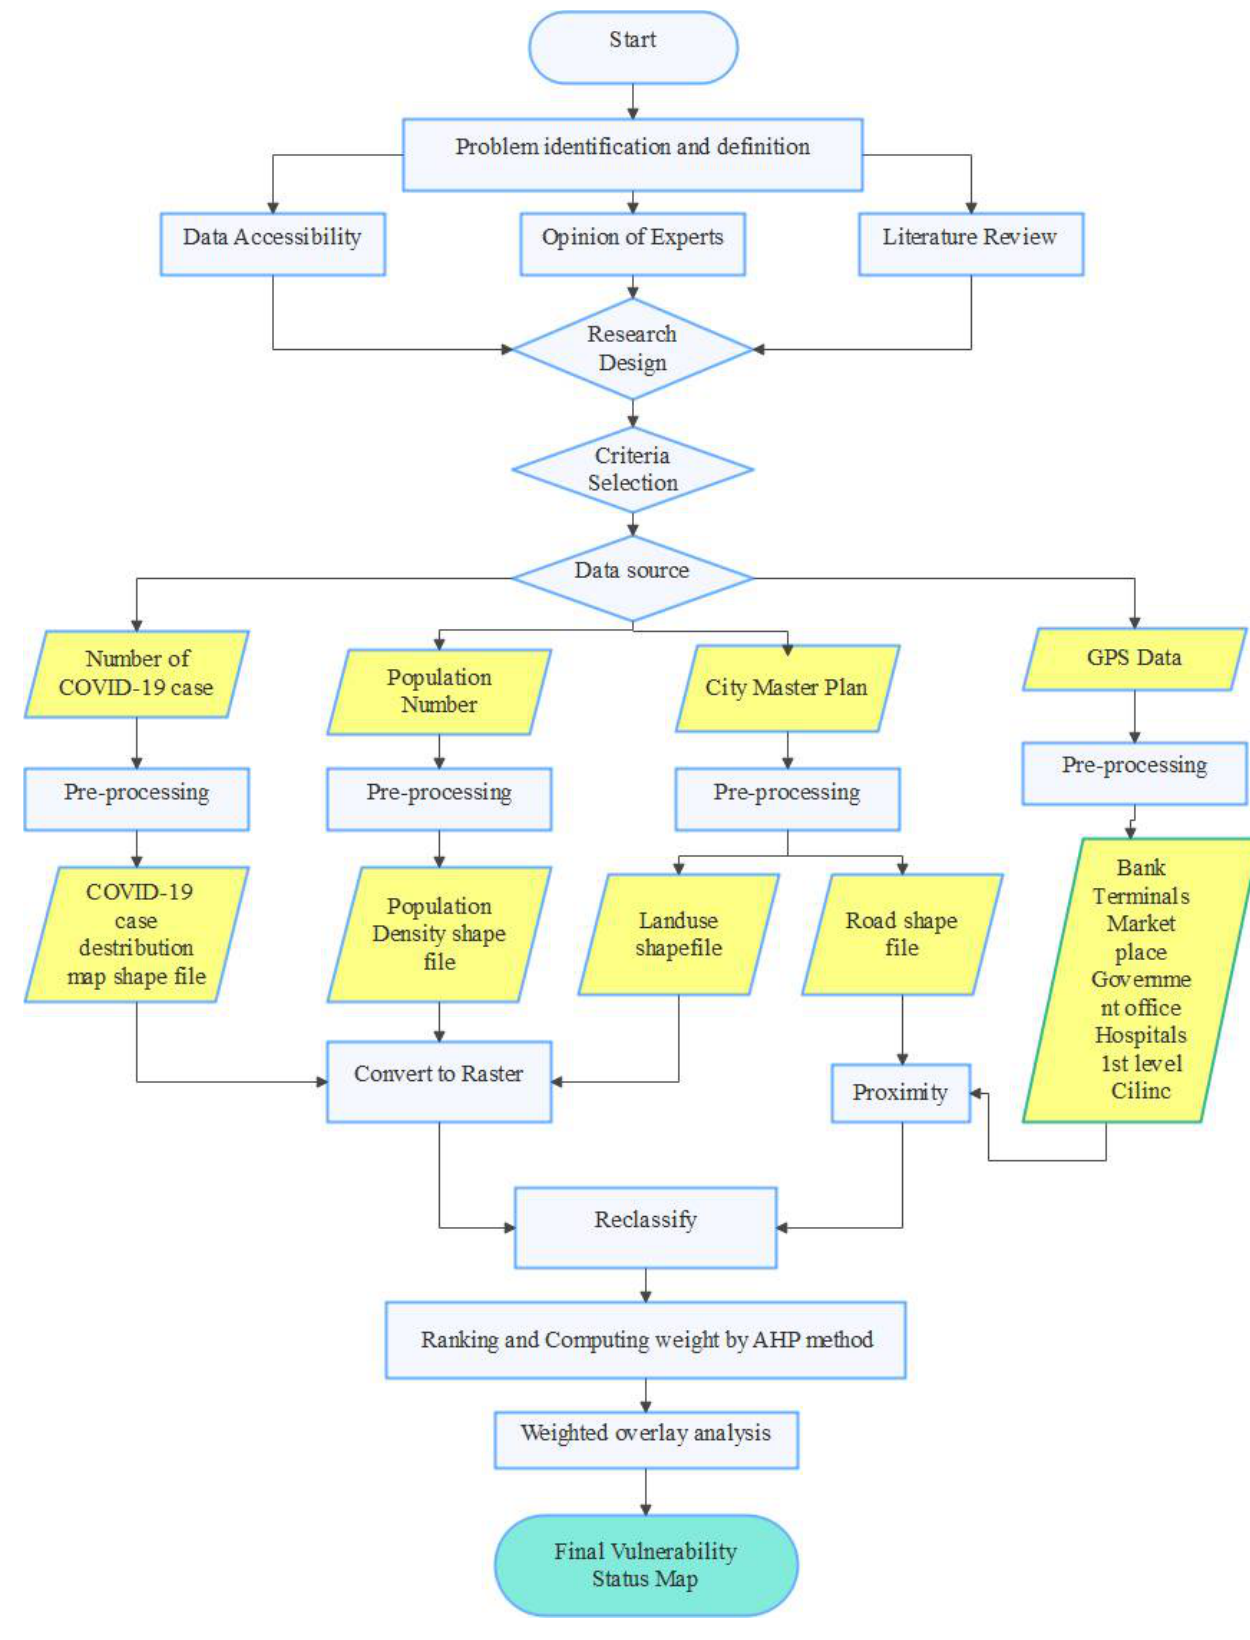
Figure 2. Technological scheme of the study.